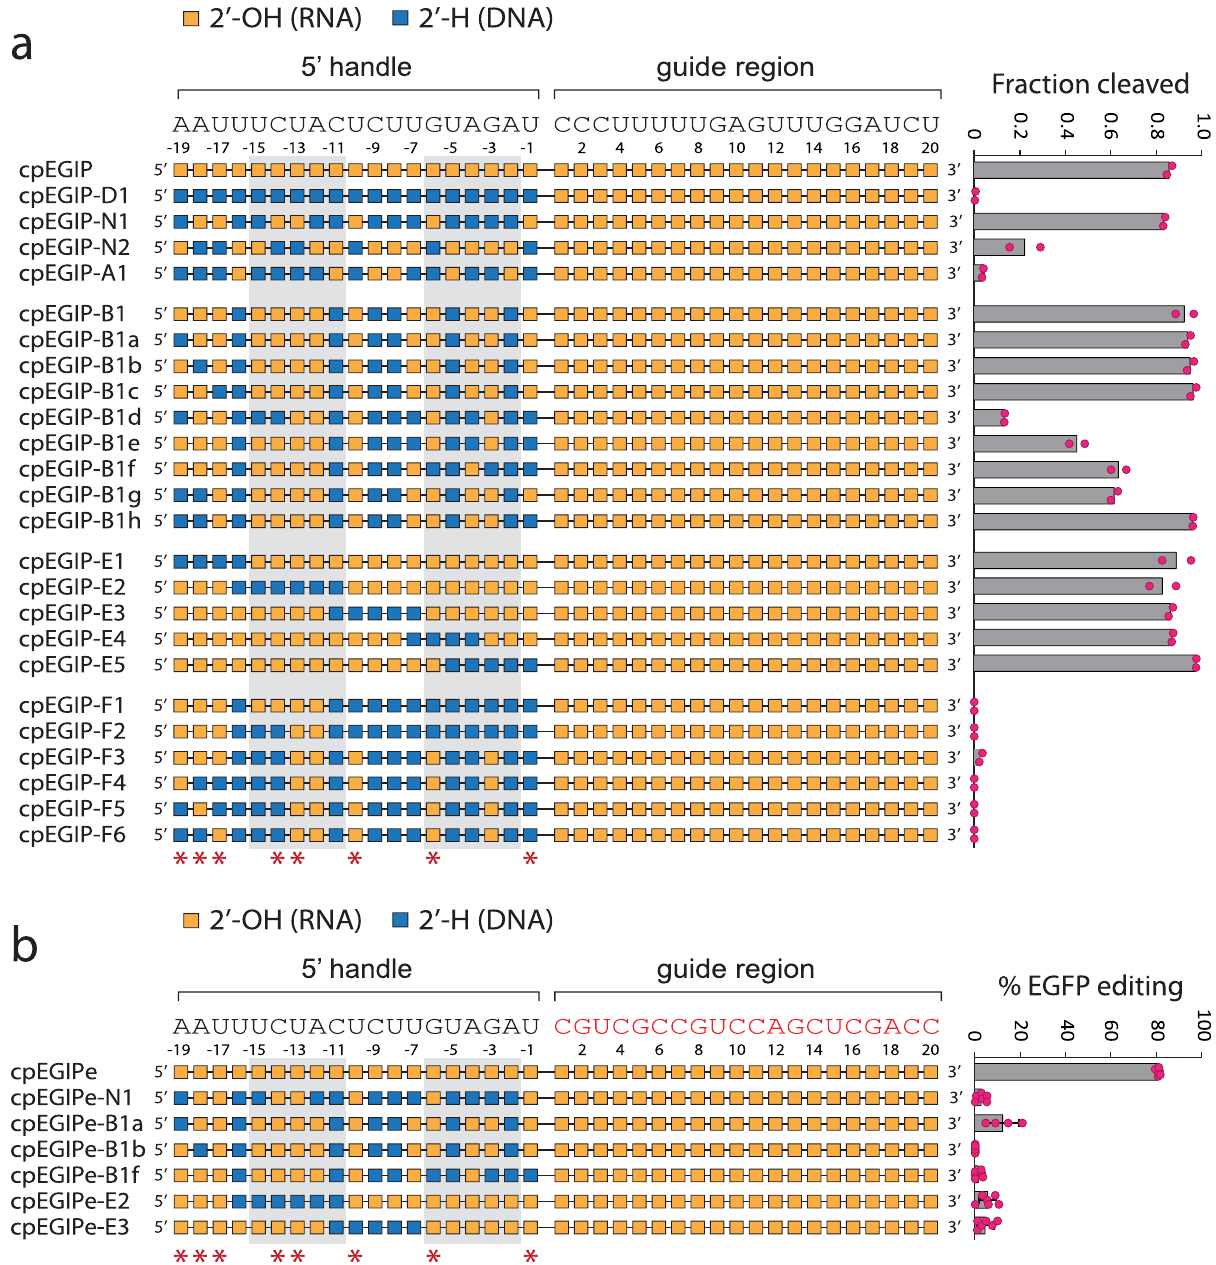
Fig. 2 In vitro cleavage and cell-based editing activity of As Cas12a using crRNA guides modi fi ed with 2 ′ -deoxyribose (DNA) nucleotides. DNA modi fi cation patterns are illustrated, with corresponding mean in vitro cleavage activity ( n = 2) ( a ) or mean cell-based editing activity ( n = 6) ( b ) shown to the right. Error bars are standard deviation and replicates are biological. For both panels, nucleotides of the 5 ′ handle that are predicted from structural data to make polar contacts through 2 ′ -OH hydrogen bonding are indicated with red asterisks below. The base-paired stem nucleotides of the 5 ′ handle pseudoknot are enclosed with light gray boxes. In vitro cleavage and cell-based editing assays utilize the distinct guide sequences that are shown above each schematic. Source data are provided as a Source Data fi